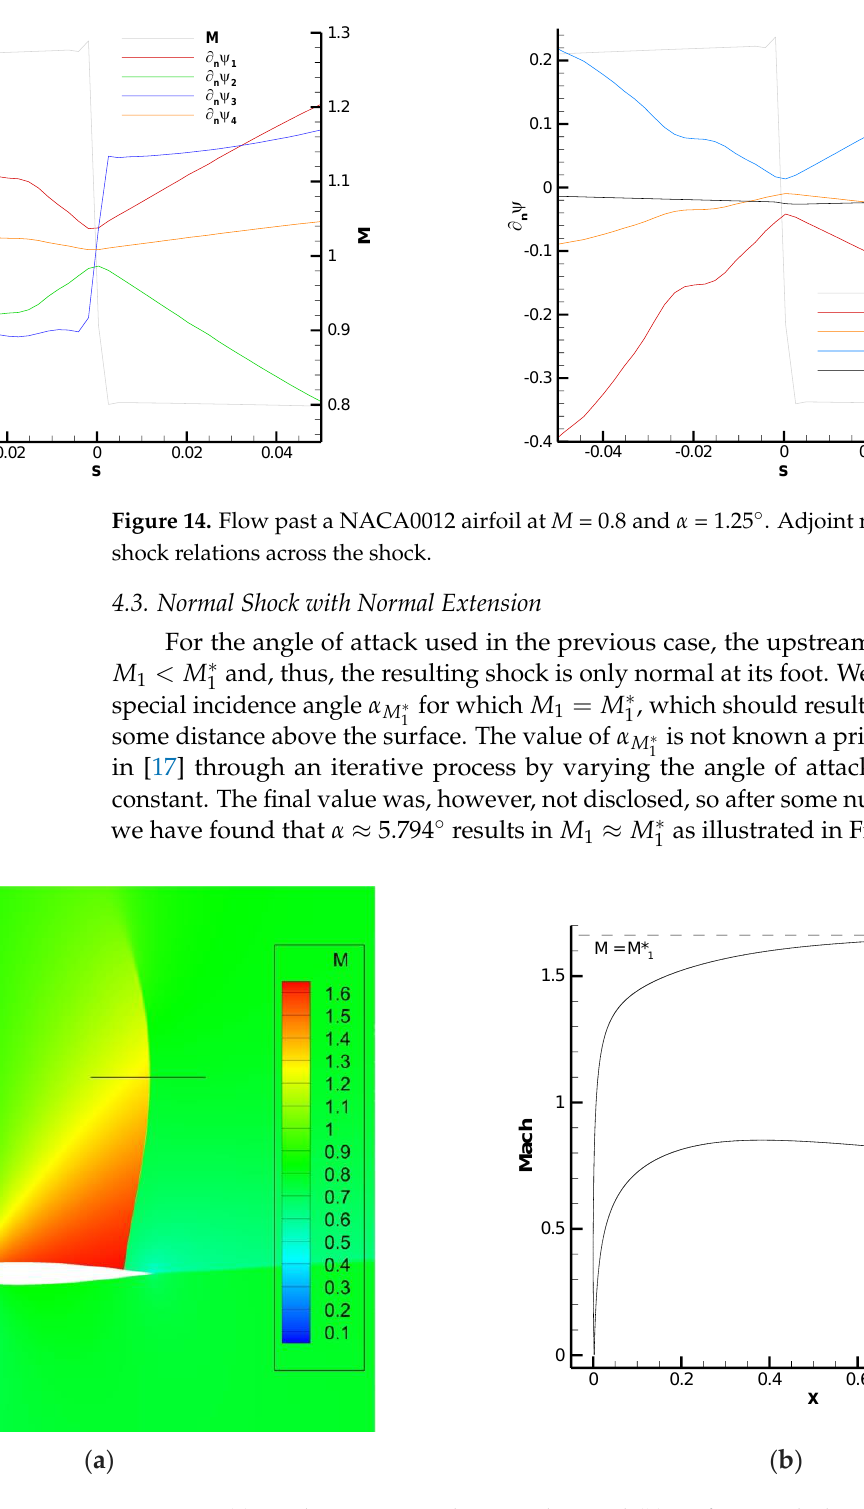
Figure 13. Adjoint variables along the cutting line indicated in Figure 12. Mach number and tangen- tial velocity are also shown for reference.